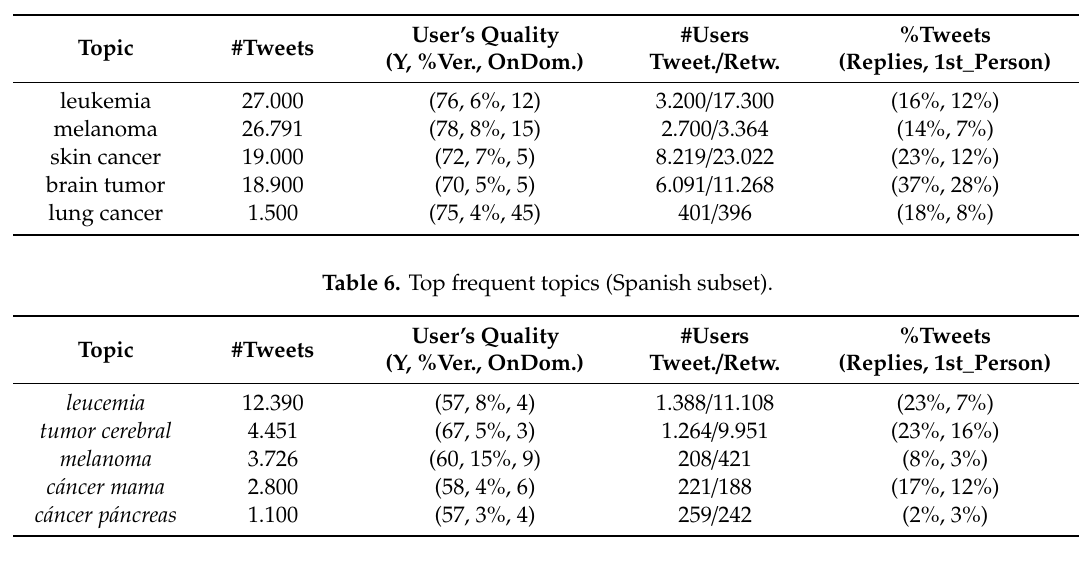
Table 5. Top frequent topics (English subset).